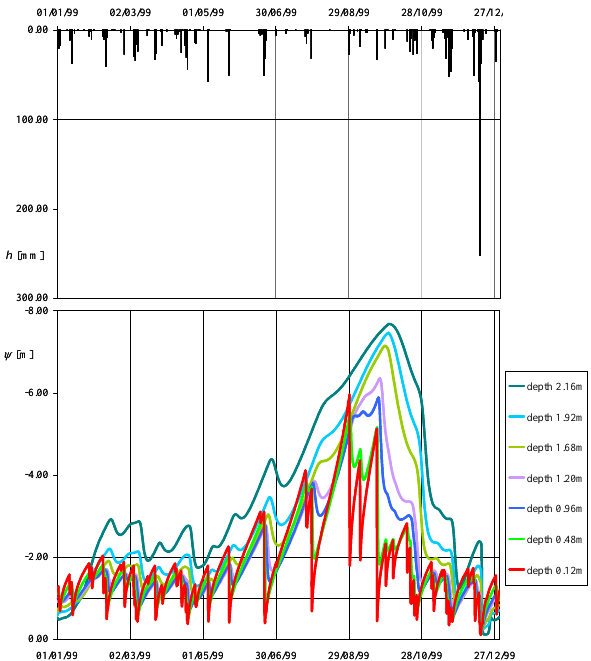
Figure 8 Fig. 8. Hourly hyetograph (above) and simulated capillary pressure Figure 7 Fig. 7. Daily hyetograph (above) and simulated capillary pressure head at various depths (below) during the rainfall event of 14 to head at various depths (below) during 1999. 16 December, when a flow slide was triggered on the early morning of 16